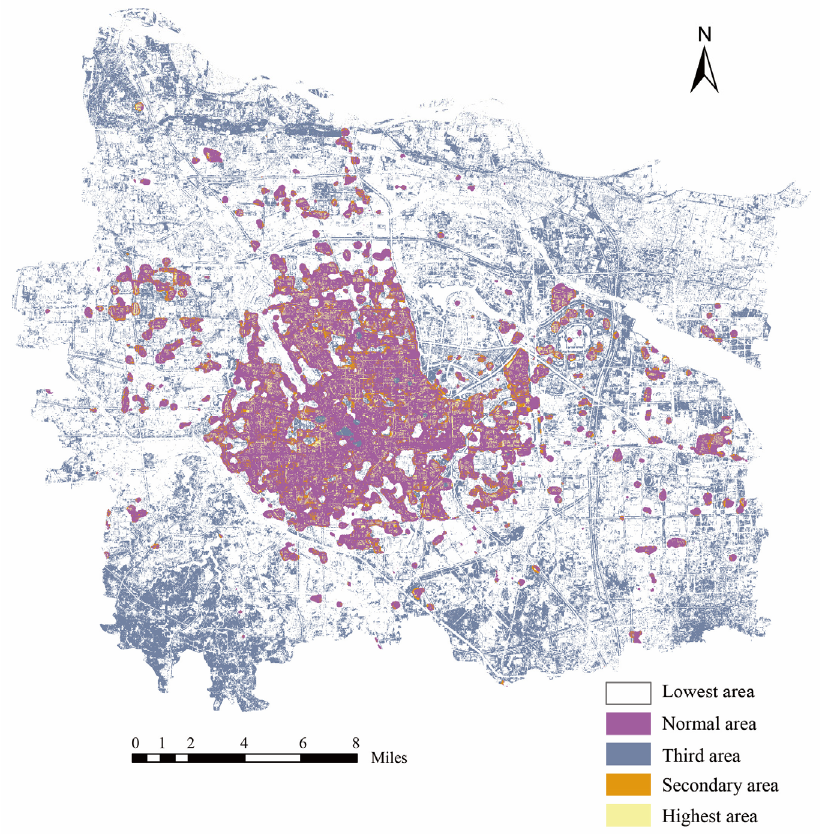
Figure 4. Different tiers of HAD by location (weekdays and weekends combined) for Zhengzhou, China.